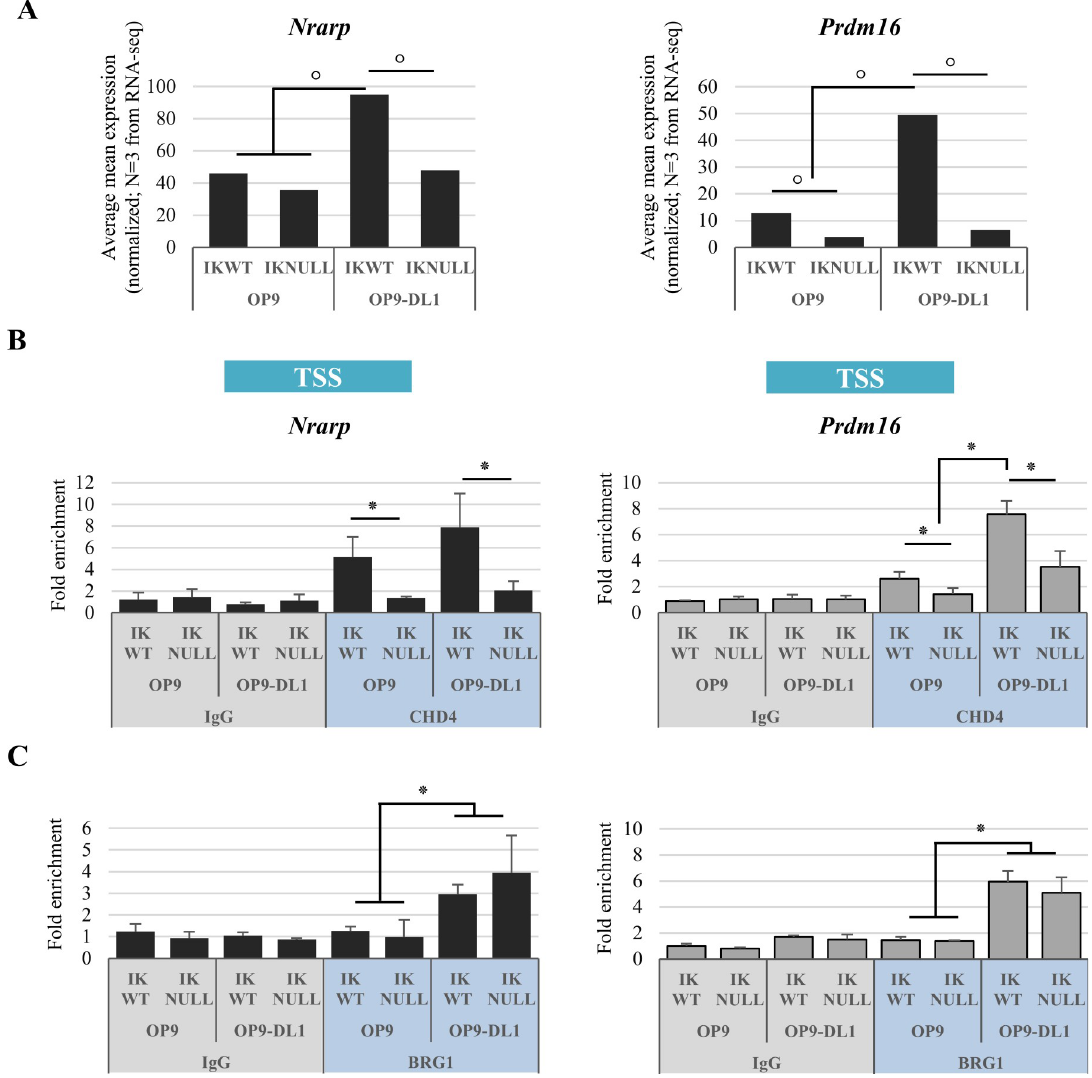
Fig 7. Characterization of Nrarp and Prdm16 genes in Ik WT and Ik Null Ter119 + cells upon NOTCH induction. (A) Gene expression; the relative expression levels of Nrarp and Prdm16 genes in Ik WT and Ik Null mouse fetal liver Ter119 + cells before (OP9 co-culture) or after (OP9-DL1 co-culture) NOTCH induction, as defined by RNA-sequencing analysis; y -axis: fold enrichment levels are represented by bars (average mean expression normalized; from the RNA-seq results; N = 3); (B, C) ChIP assays with CHD4, BRG1 antibodies (blue) or isotype-matched IgG (grey) were conducted in Ik WT or Ik Null Ter119 + cells co-cultured with OP9 or OP9-DL1 cells; immunoprecipitated and unbound (input) chromatin samples were used as templates in qPCR analysis with primers specific for Nrarp or Prdm16 TSS; y-axis : fold enrichment levels calculated according to the Pfaffl equation using Thp1 promoter region as internal control, are represented by bars and plotted as the mean ± Standard Deviation of the measurements; a value of 1 indicates no enrichment; data shown are the results of three independent experiments; ˚: p � 0.05 by Student’s t